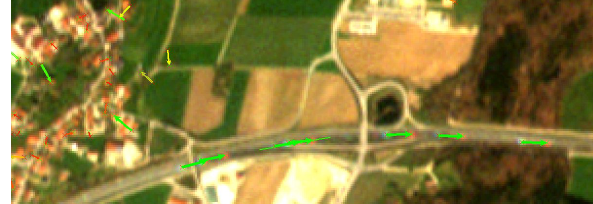
Figure 21: Objects found in part RapidEye Scene, 6 × 2 km 2 , A96 near Sch¨offelding, green arrows denote movement of ob- jects, green line across cars in center for profile in fig. 22